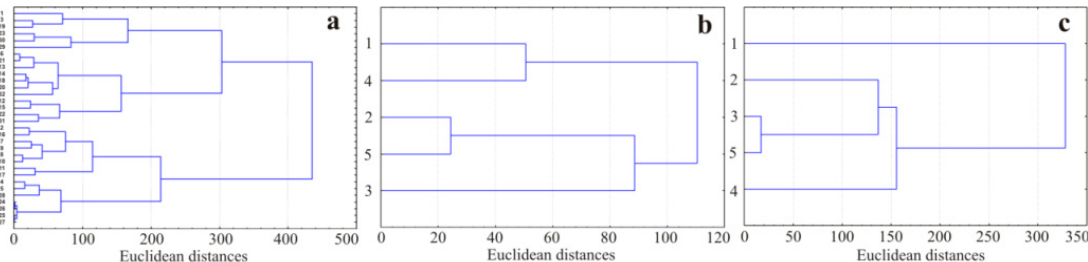
Figure 3. The dendrogram of similarity in relation “salinity — 90 Sr concentration” between samples taken from the studied Crimean lakes (a sample number was given in Table 1): ( a ) for all samples, ( b ) for samples taken from Lake Kirleutskoye, ( c ) for samples taken from Lake Kiyatskoye.